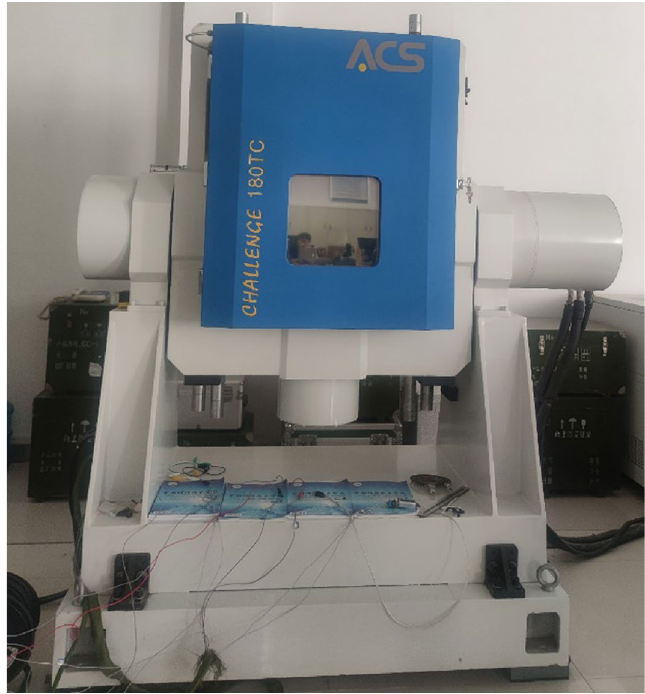
Figure 1. CH180TC temperature control box.